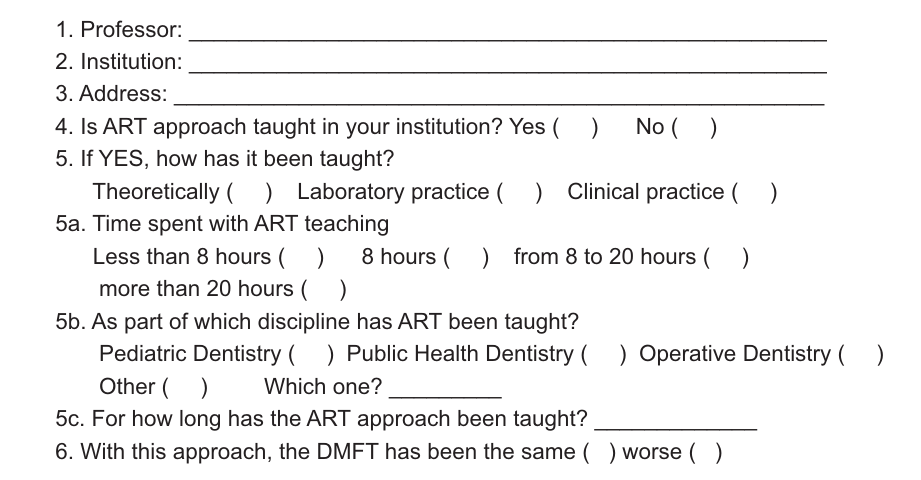
FIGURE 1- Questionnaire on teaching ART in dental institutions in